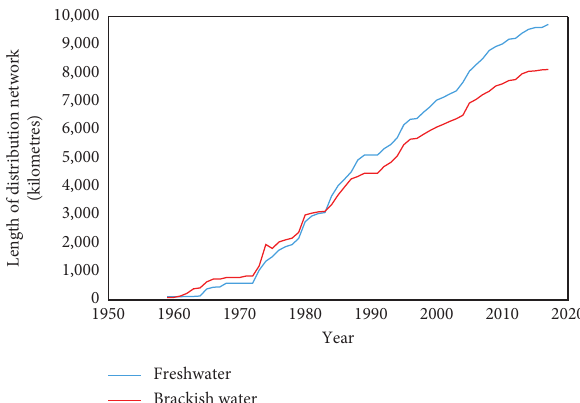
Figure 1: Development of fresh and brackish water distribution